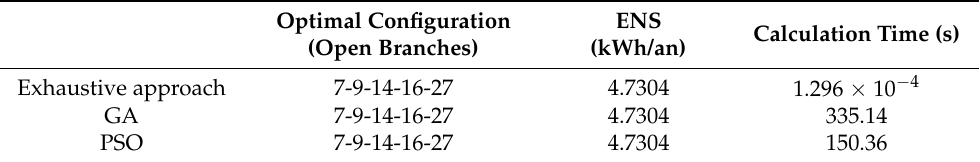
Table 1. Comparison between the proposed approaches for the minimization of the energy not supplied